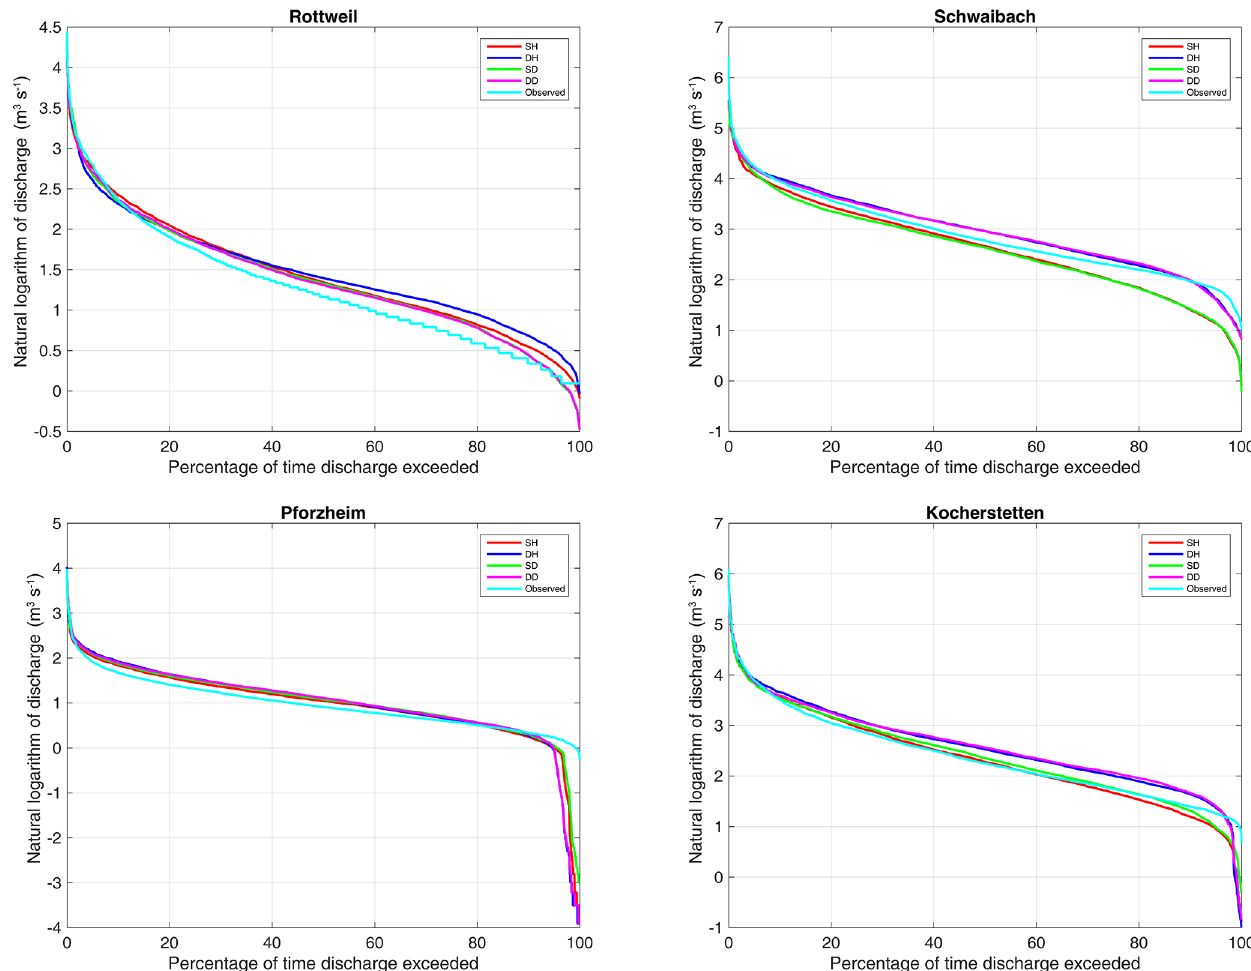
Figure 6. Comparison of the simulated flow duration